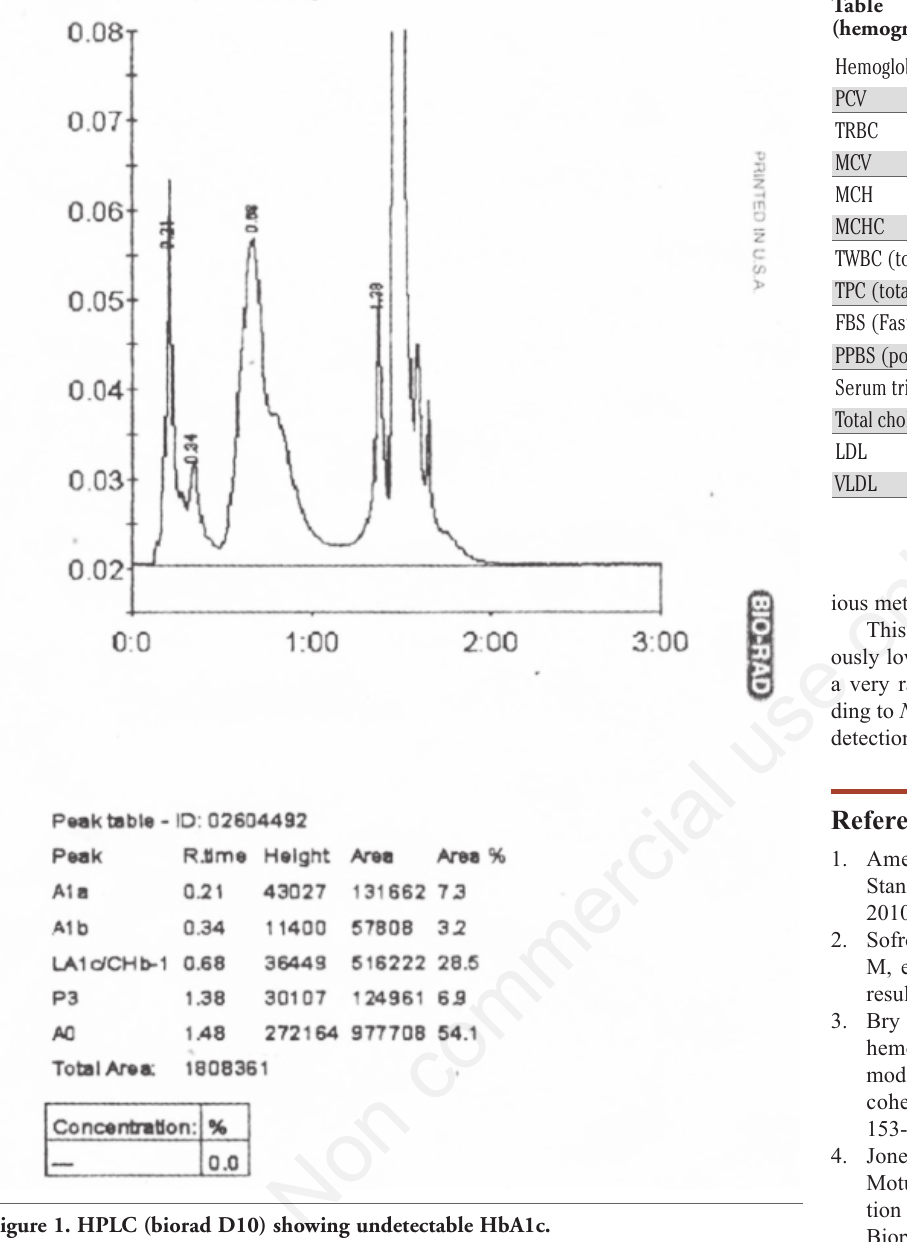
Figure 1. HPLC (biorad D10) showing undetectable HbA1c.